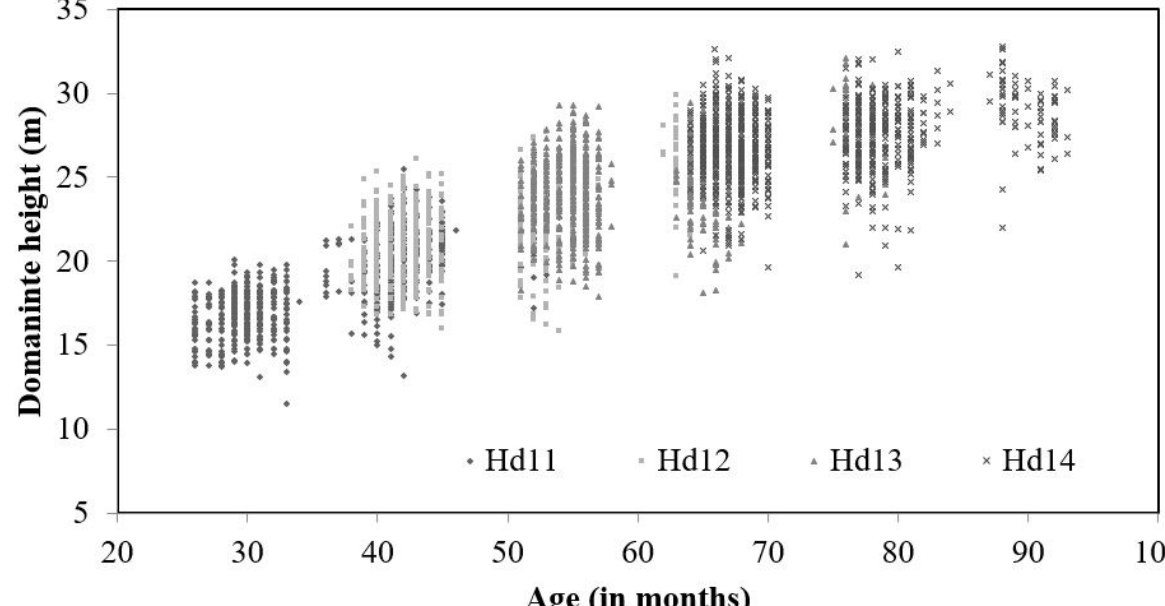
Figure 1. Distribution of the data to Eucalyptus sp. in a tropical region of